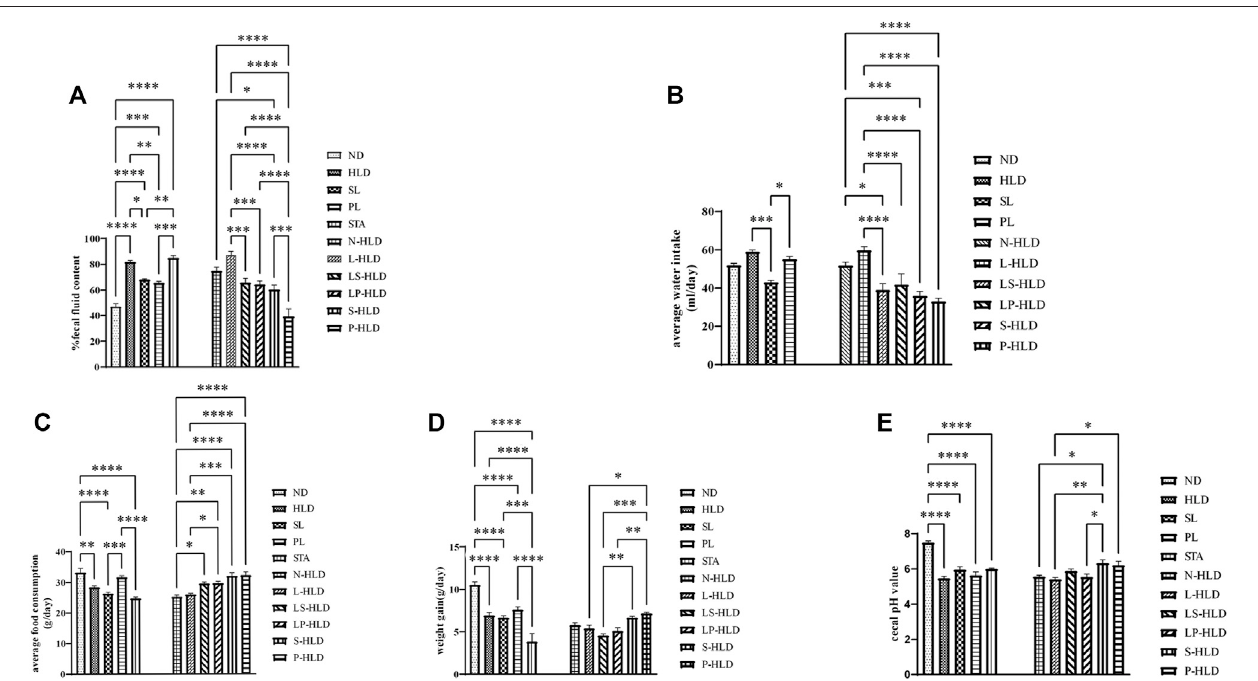
FIGURE 2 | Effects of SL, polysaccharides derived from SL and CMT intervention on HLD rats (A) SL, polysaccharide and CMT intervention signi fi cantly reduced fecal fl uid content (B) SL signi fi cantly reduced water intake compared to HLD group (left panel). LS-HLD, LP-HLD, S-HLD and P-HLD signi fi cantly decreased water intake compared to the L-HLD or N-HLD groups (C) Compared to the L-HLD group, S-HLD and P-HLD signi fi cantly increased average food consumption, promoted weightgain (D) andincreasedthececalpHvalue (E) .Statisticalsigni fi cancewasdeterminedusingone-wayANOVA,followedbyTukey ’ stest.* p ≤ 0.05,** p ≤ 0.01, and *** p ≤ 0.001 n = 6-8 per